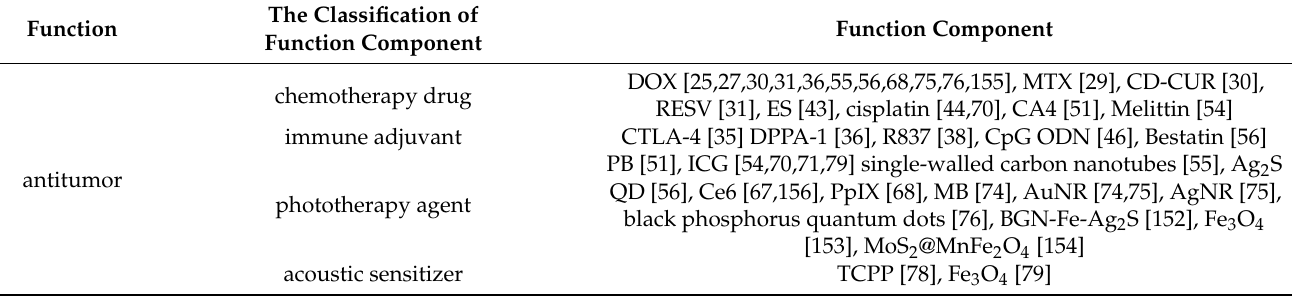
Table 1. The classification of hydrogel functional